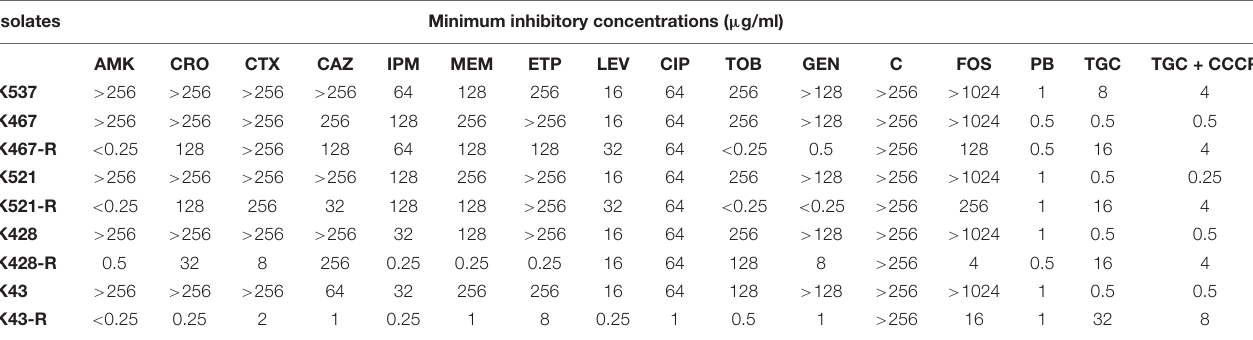
TABLE 1 | Antimicrobial susceptibility of five CRKP clinical isolates and four resistance-induced descendant strains.